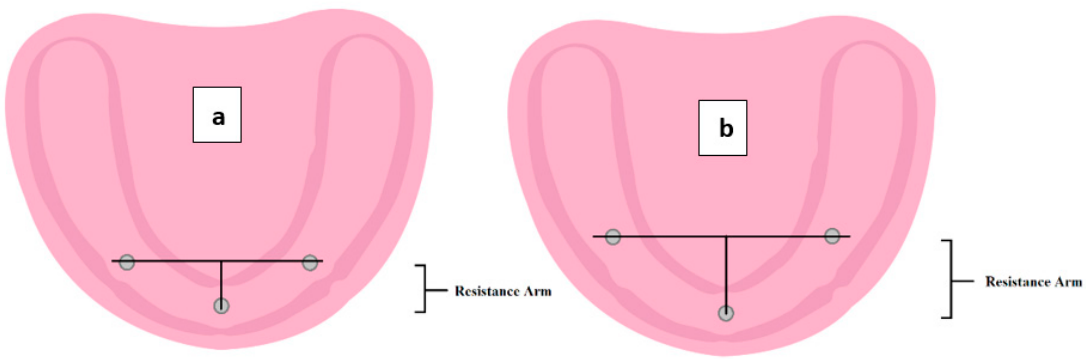
Figure 7. The difference in resistance arm length; note the increase in the length of the resistancearm in model ( b ) compared to ( a ) by moving the two posterior MDIs in model ( b ) compared to ( a ) by moving the two posterior MDIs distally.